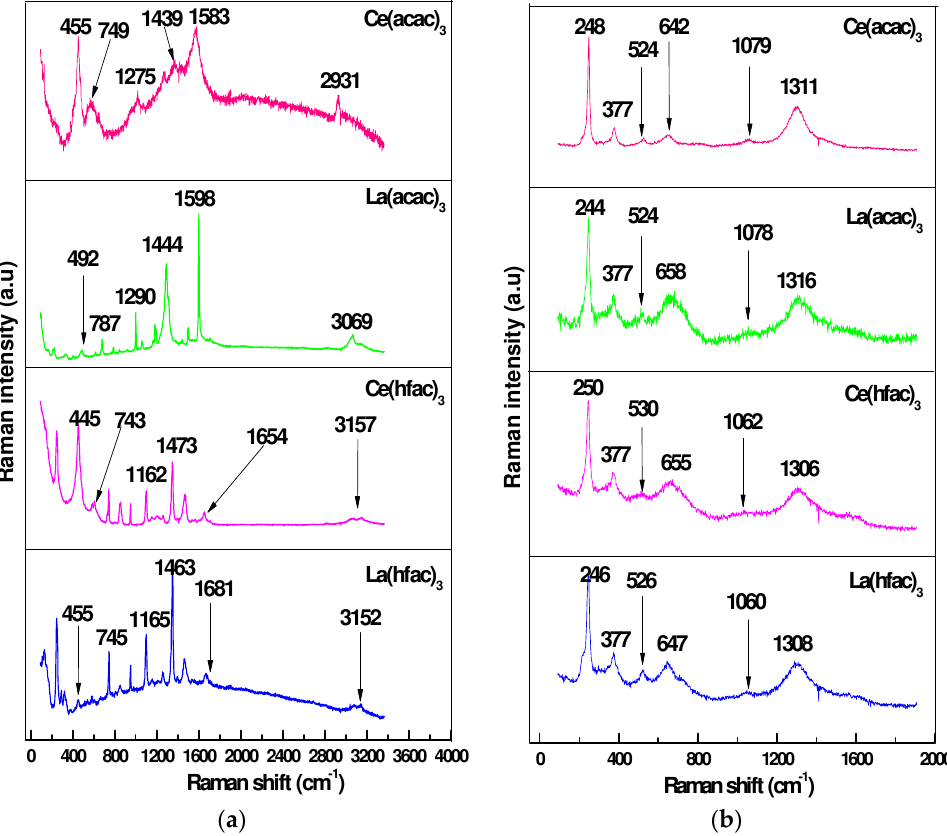
Figure 13. Raman spectra of Ce ( acac ) corrosion products formed on mild steel and 303 SS: ( a ) REE β -diketone inhibitor; ( b ) steel REE β -diketone inhibitor